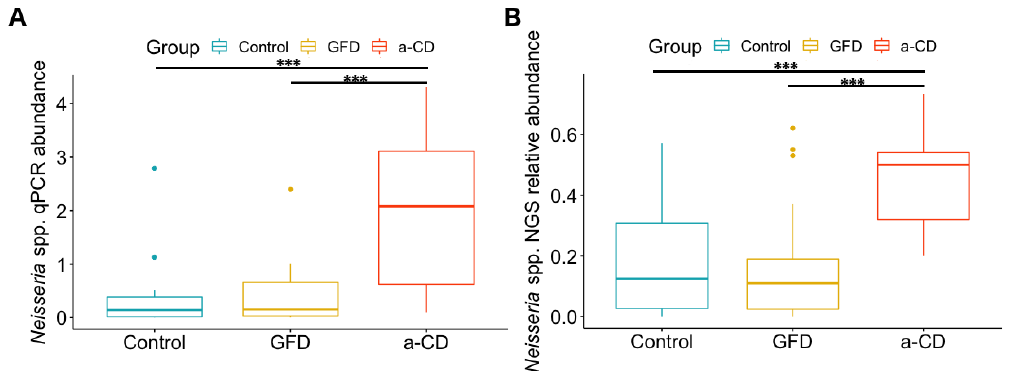
Figure 1. Boxplot showing the abundance distribution of Neisseria spp. in Control, Gluten Free Diet (GFD) and active Celiac Disease (a-CD) groups as obtained by qPCR ( A ) and by NGS analyses ( B ). Neisseria NGS relative abundance refers to a percentage with respect to the whole amount of the detected species. Boxes range from the first to third quartile and whiskers extend to the maximum and minimum values. The line inside the box is the median. Data beyond the end of the whiskers are outliers, which are plotted as points. The significance between groups was calculated through ANOVA and the post-hoc test Tukey’s “Honest Significant Difference”. Significant codes for p - adjusted values: *** p < 0.001.